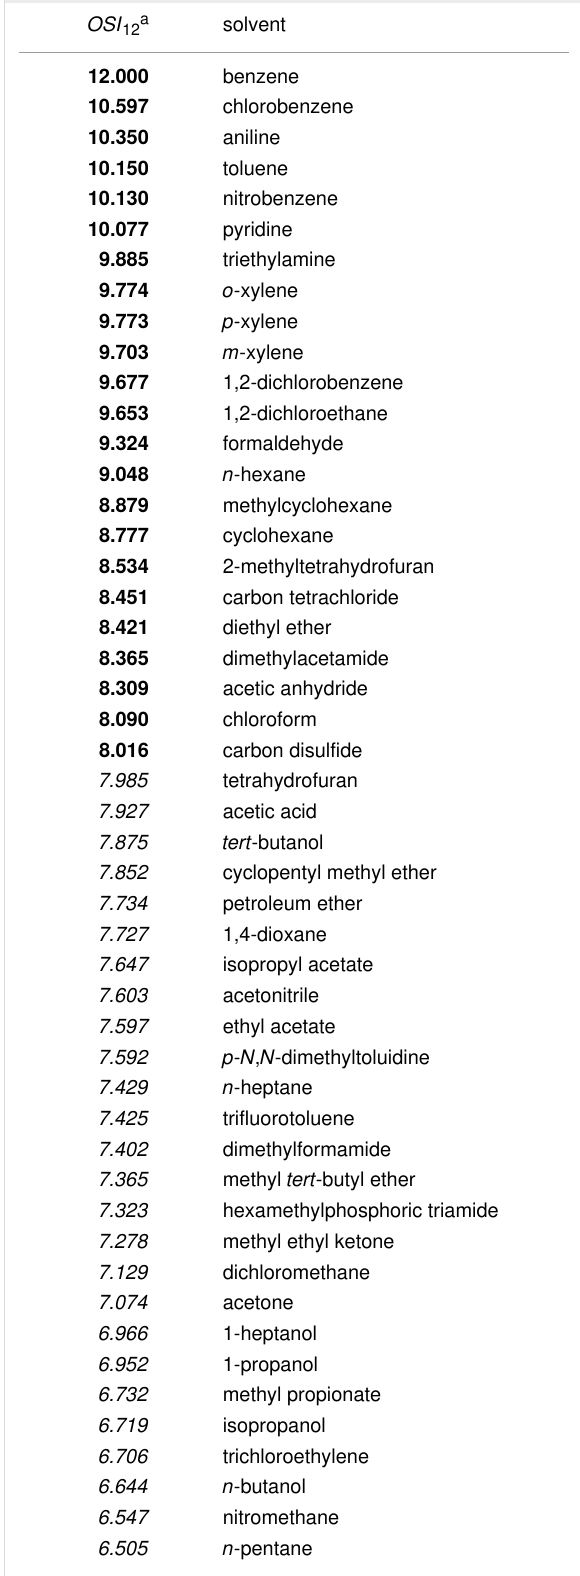
Table 1: Revised summary of overall solvent index (OSI) for various organic solvents used in the pharmaceutical